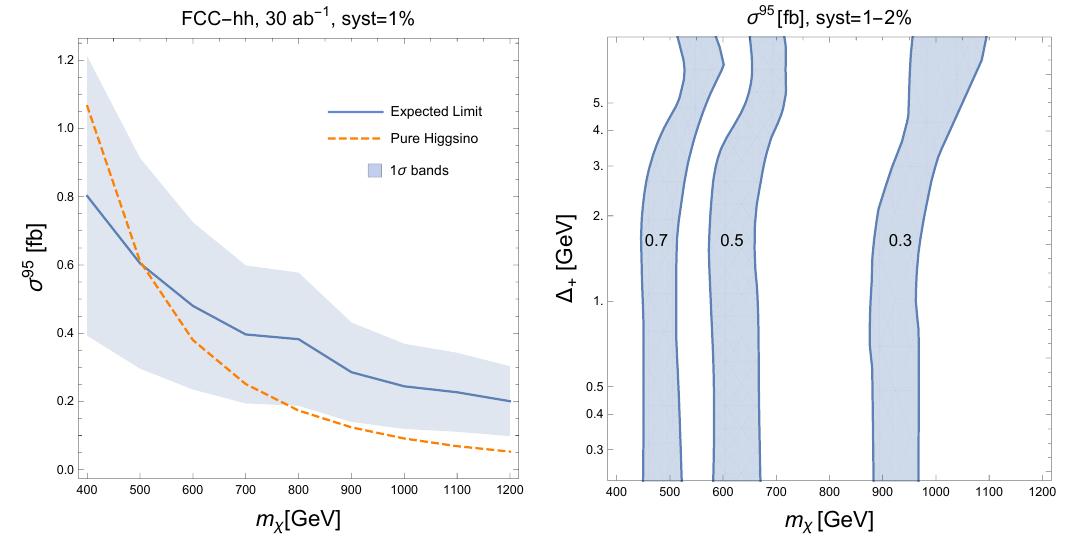
Figure 6 . (Left panel) Median expected limit on the inclusive cross section (cid:22) (cid:31)(cid:31) + ( Z ! ‘ + ‘ (cid:0) ) at 95% CLs, (cid:27) 95 (continuous blue line) and 1 (cid:27) bands (shaded region), as a function of dark sector mass, for negligible splitting and a background systematic uncertainty of 1%. The expected cross section for a pure higgsino with nominal splitting is shown for comparison (dashed line). (Right panel) Contours of (cid:27) 95 as a function of dark sector mass and splitting, for background systematic uncertainties of 1{2%. Results were computed for a weak doublet with hypercharge 1/2 and nominal splitting, at FCC-hh, for a total integrated luminosity of 30 ab (cid:0) 1 . See text for range of applicability of